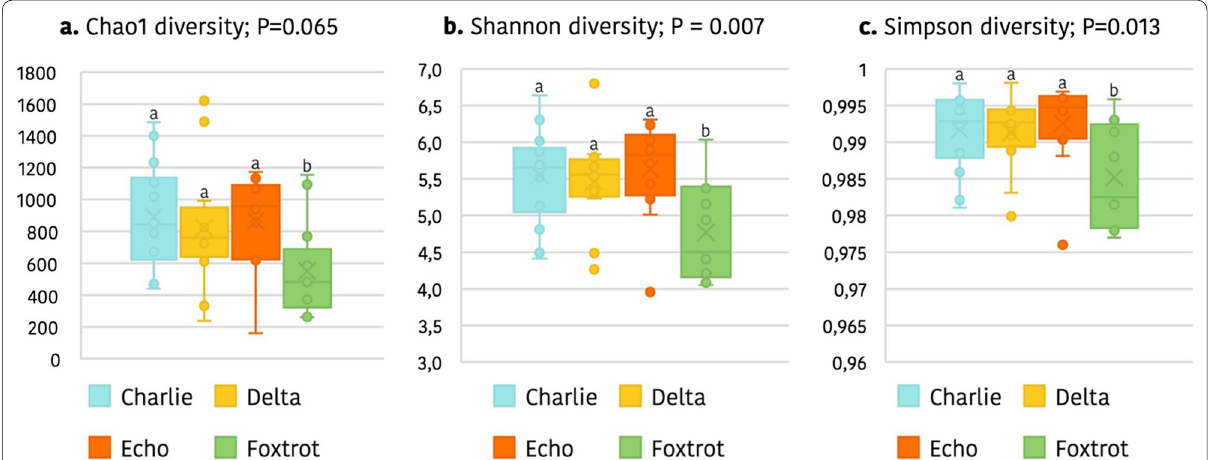
Fig. 5 Box plot of the alpha diversity calculated using the Chao1 ( a ), Shannon ( b ) and Simpson indices ( c ) of the four farms included in Trial 2 in 2‑day‑old piglets. The Foxtrot farm showed lower alpha diversity values than the rest of the farms, suggesting a possible effect of maternal medicated